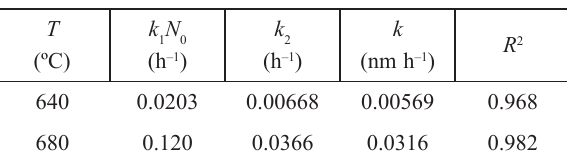
Table 4 – Parameters for the kinetic model (9) with m = 1, for transformation from anatase to rutile in pres- ence of alumina (Fig.